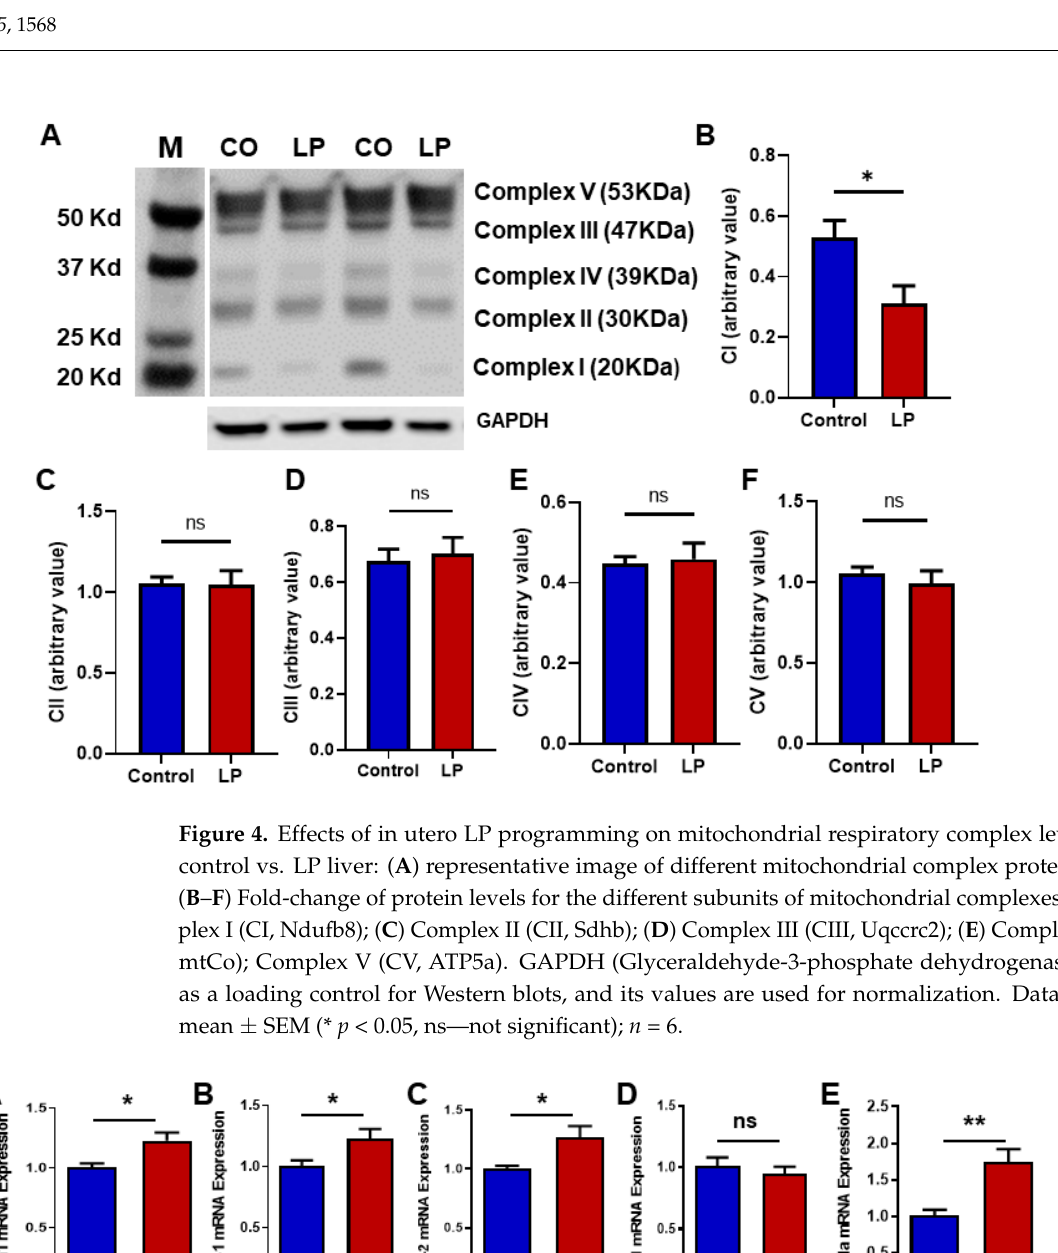
Figure 6. LP programming associated changes in mitochondrial dynamics and biogenesis protein content in the liver of the control and LP rats: ( A ) representative Western blots of mitochondrial dynamics and biogenesis genes tested in the controls (CON) and low-protein (LP) groups; ( B – G ) relative expression of the different genes: ( B ) ESSRA; ( C ) OPA1; ( D ) PGC1A; ( E ) FIS1; ( F ) MFN1; ( G ) MFN2. The blot density is calculated by densitometry scanning and normalized to GAPDH. Data represent mean ± SEM (* p < 0.05, ns—not significant); n = 8. We quantified the mRNA expression levels for mitochondrial fusion genes such as Opa1, Mfn1 , and Mfn2 , and fission genes Drp1 and Fis1 . The qPCR analysis shows that Opa1 was increased ( p < 0.05) in the LP-programmed liver when compared with the con- trols (Figure 5A). Likewise, Mfn1 and Mfn2 genes were upregulated ( p < 0.05) in the LP liver in comparison with the control (Figure 5B,C). However, the fusion gene Fis1 (Figure 5D) and Drp1 (Figure 5J) mRNA expressions in the LP were not significantly different from the control. The mitochondrial biogenesis-associated gene, Pgc1a, was found to be significantly upregulated ( p < 0.01) in the LP-programmed liver group when compared with the con- trols (Figure 5E). Pgc1b , another mitochondrial biogenesis-associated gene, exhibited a